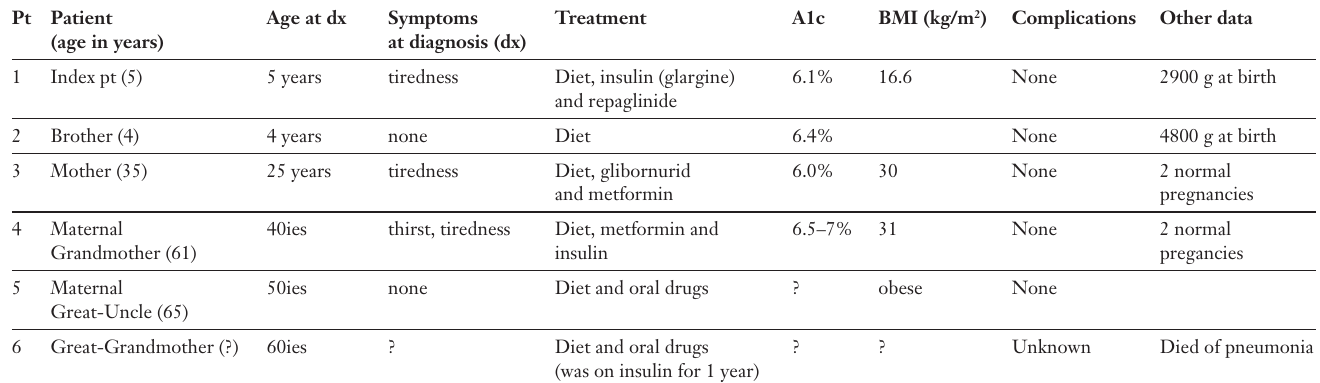
Table 1 Clinical characteristics of the